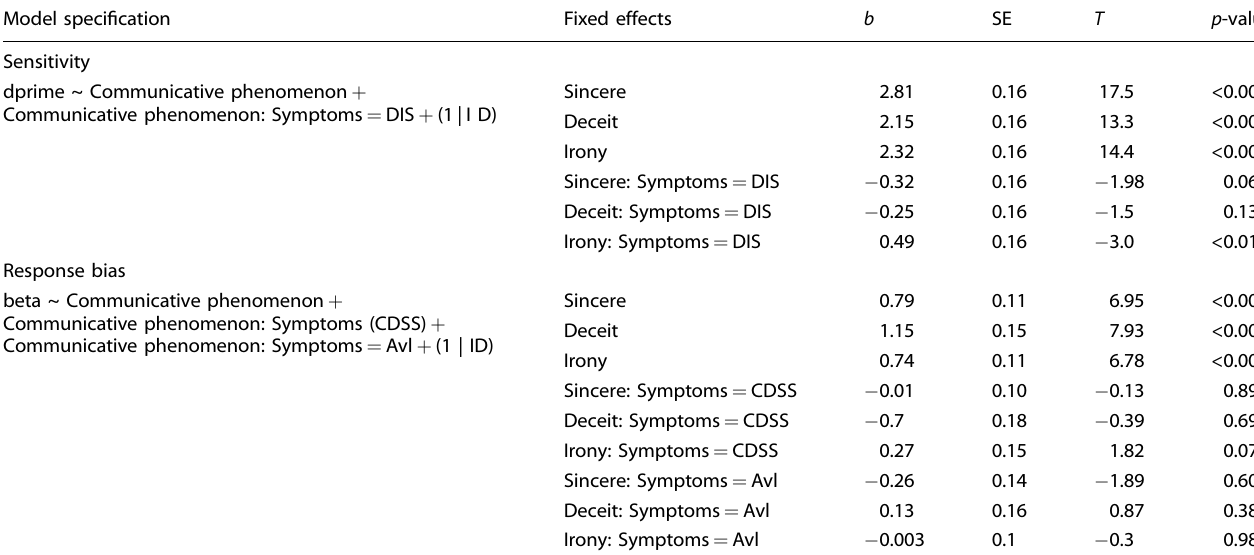
Table 5. Selected models for the clinical factors predicting sensitivity and response bias in the SCZ